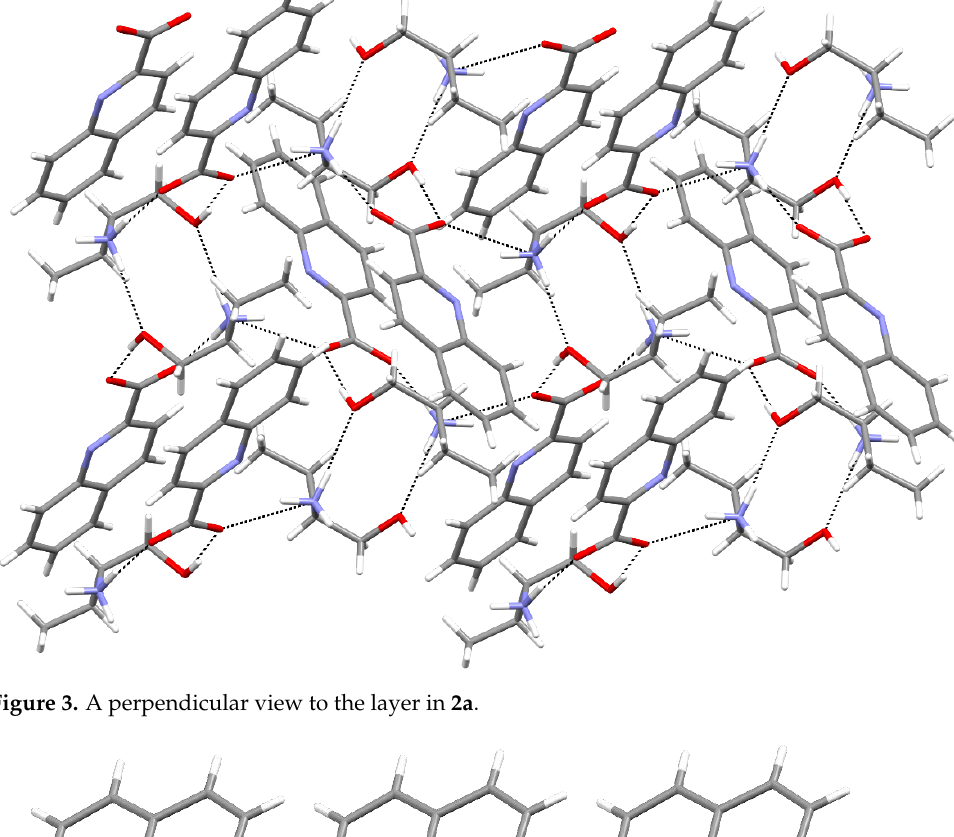
Figure 3. A perpendicular view to the layer in 2a .